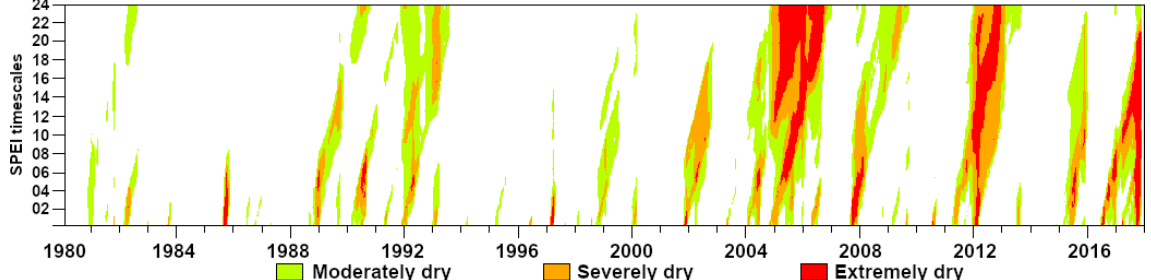
Figure 3. Temporal evolution of moderately, severely, and extremely dry conditions in the MLSHD according to the SPEI at a temporal scale of 1 to 24 months and the classification shown in Table 1. Period of 1980–2017.